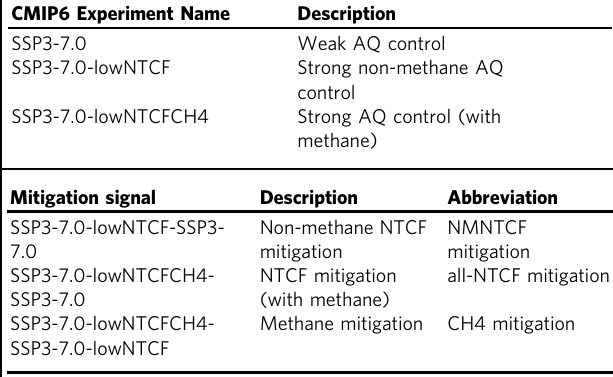
Table 1 De fi nition of coupled ocean-atmosphere-chemistry experiments and mitigation signals used in this